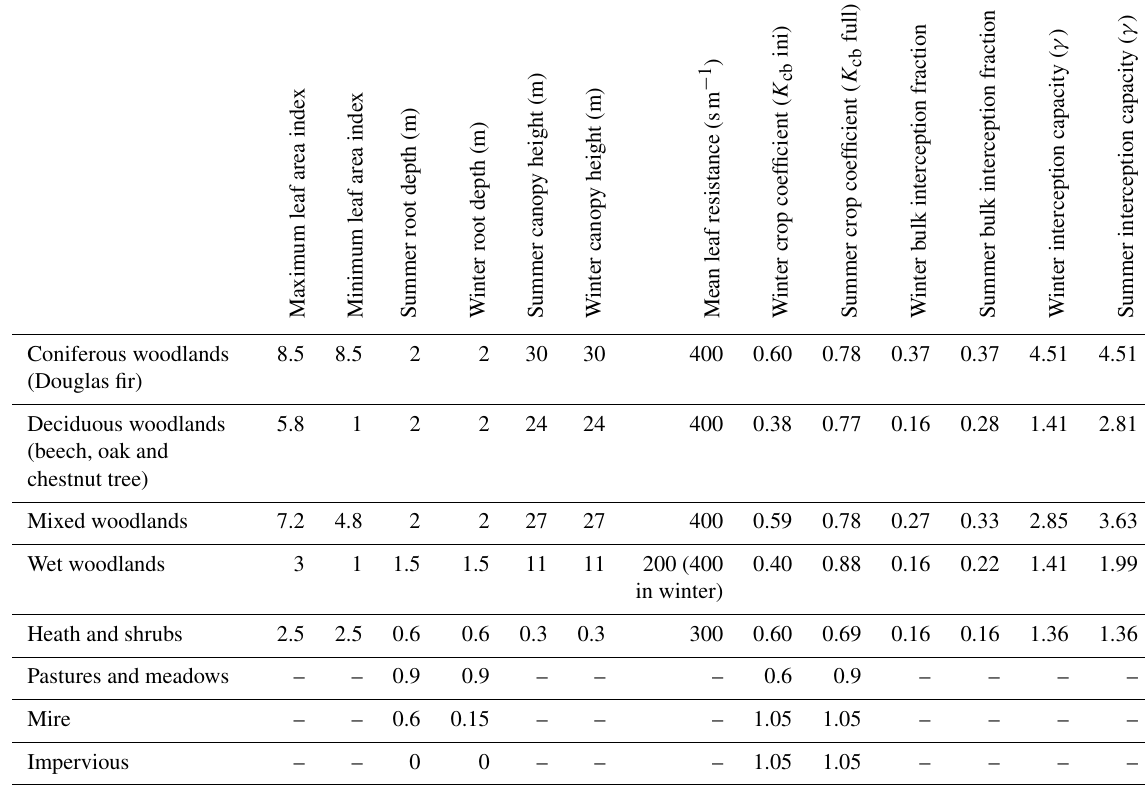
Table 2. Parameterisation of the evapotranspiration